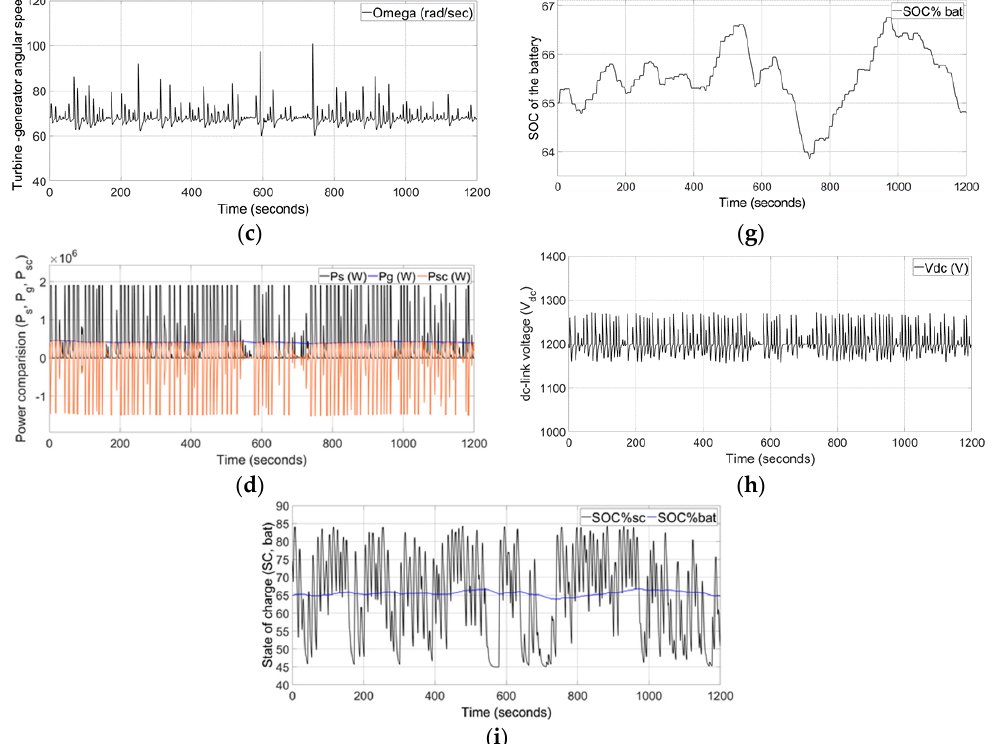
Figure 3. First case study. ( a ) VOWC chamber pressure head, ( b ) air-turbine mechanical torque (Tm), ( c ) turbine-generator rotor angular speed ( ω m ), ( d ) power comparison of VOWC generator power (P s ), grid power (P g ), and supercapacitor power (P sc ), ( e ) Li-ion battery power (P bat ), ( f ) grid power (P bat ), ( g ) state of charge of the of the battery (SOC bat ), ( h ) DC-link Voltage (v dc ), ( i ) state of charge of the supercapacitor (SOC sc ) and battery (SOC bat ).